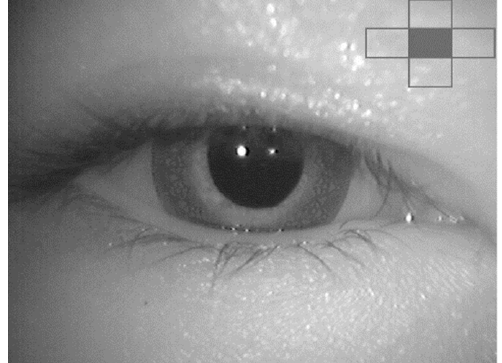
Figure 18. Sample of a video frame from Video No.